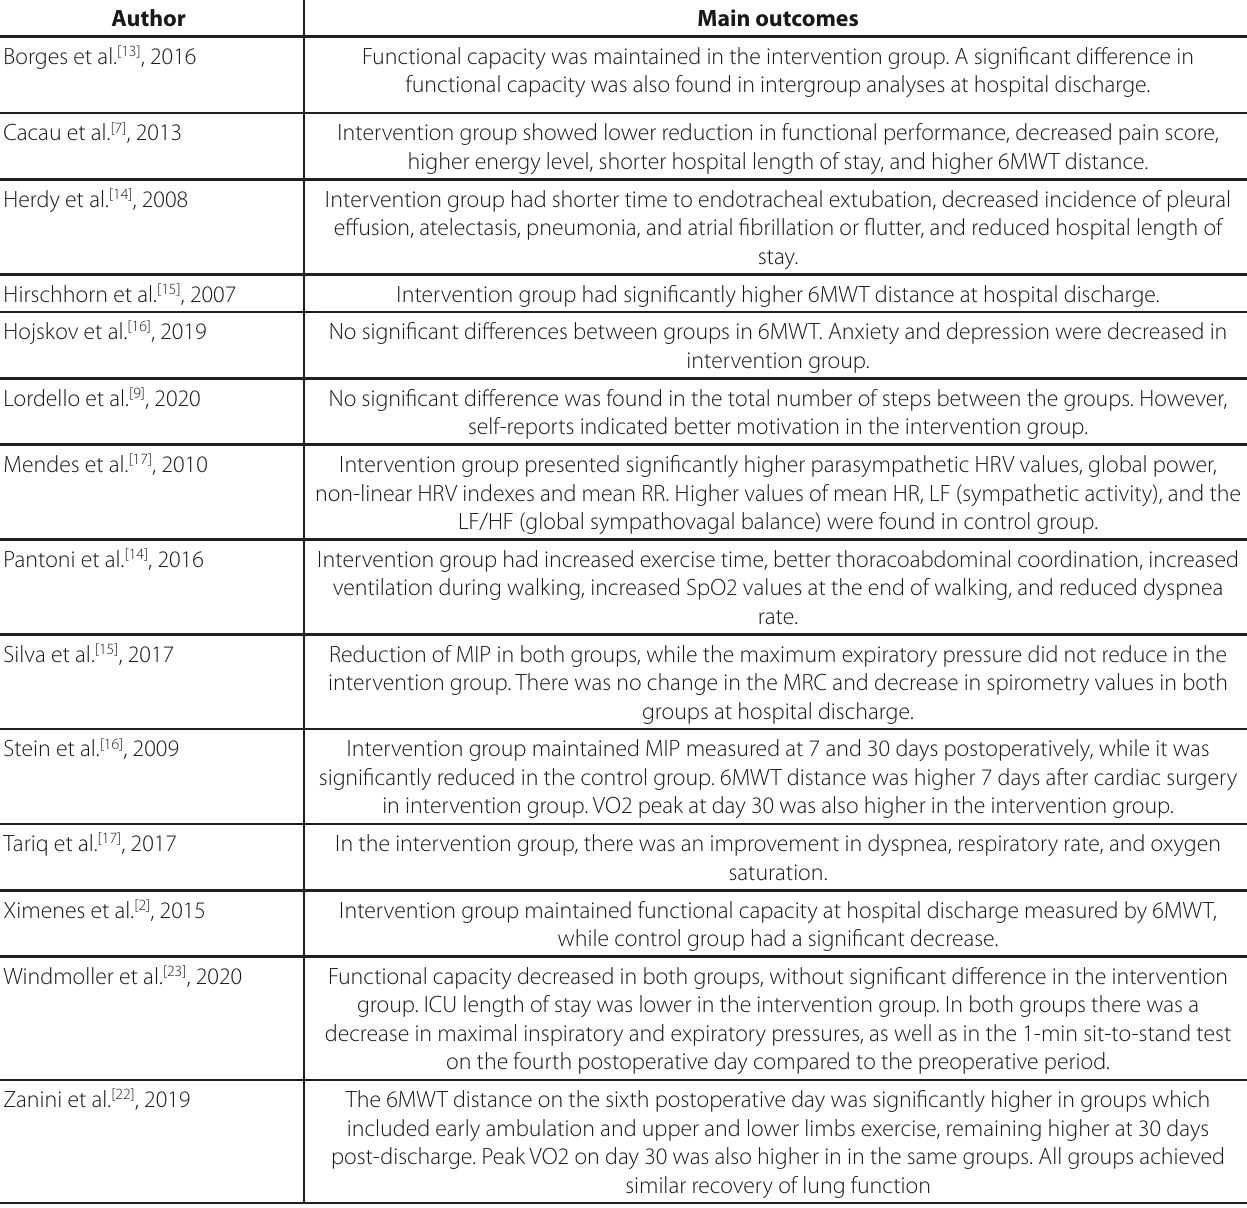
Table 4 . Main outcomes of the included